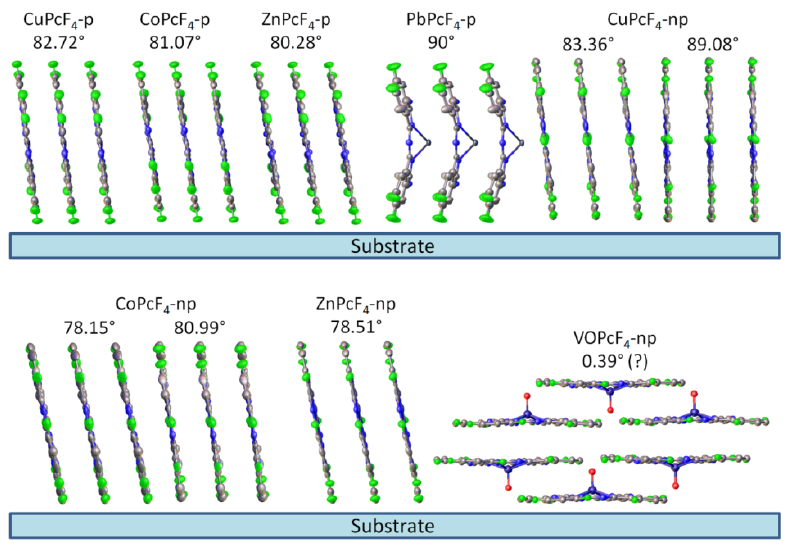
Figure 3. Orientation of MPcF 4 -p and MPcF 4 -np molecules relative to the substrate surface. The morphology of the films was studied by atomic force microscopy. The